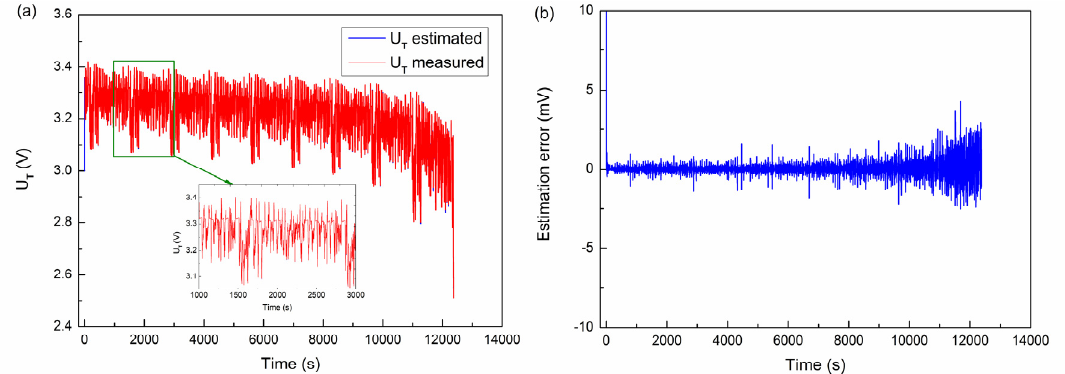
Figure 19. Validation of the identification method in the FUDS test at 20 °C: ( a ) the estimated voltage and measured voltage profiles and ( b ) the estimation